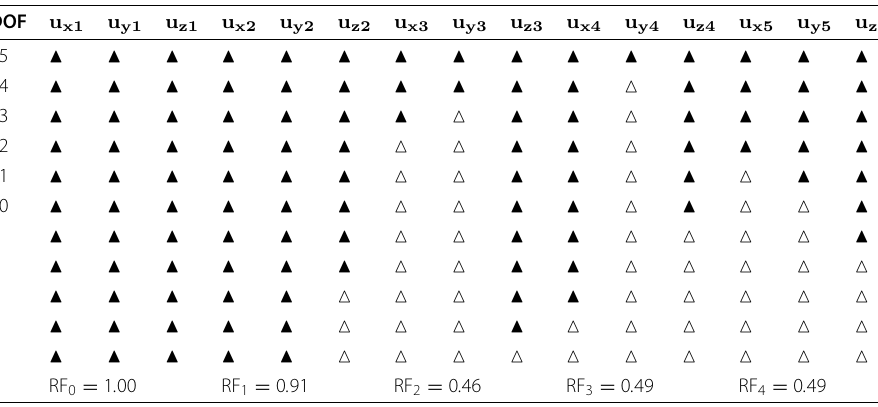
Table 16 BTD models, 0/90/0, a/h =